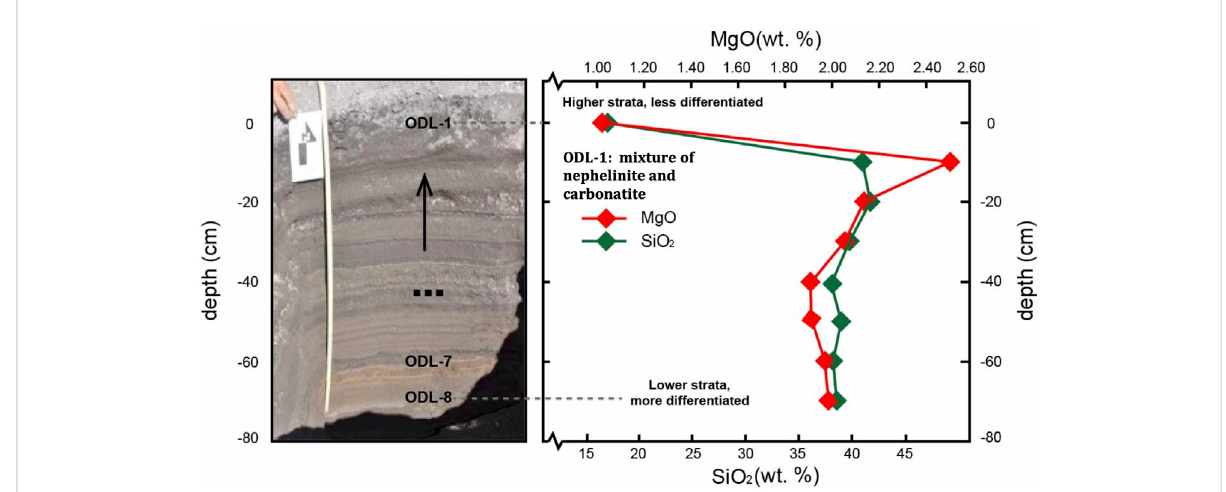
FIGURE 2 ODL zoned tephra from 2008 in stratigraphic view with compositional pro fi le in SiO 2 and MgO. Note MgO increase up section, consistent with expectation ofpre-eruptionthermal zoning ofmagma chamber.However, unlike all other magmasystemson Earth, SiO 2 increasesup section (with decreasing differentiation index). ODL-1 represents a mixture of nephelinite and carbonatite, possibly consistent with it being the CO 2 rich silicate melt below the mush at the time of